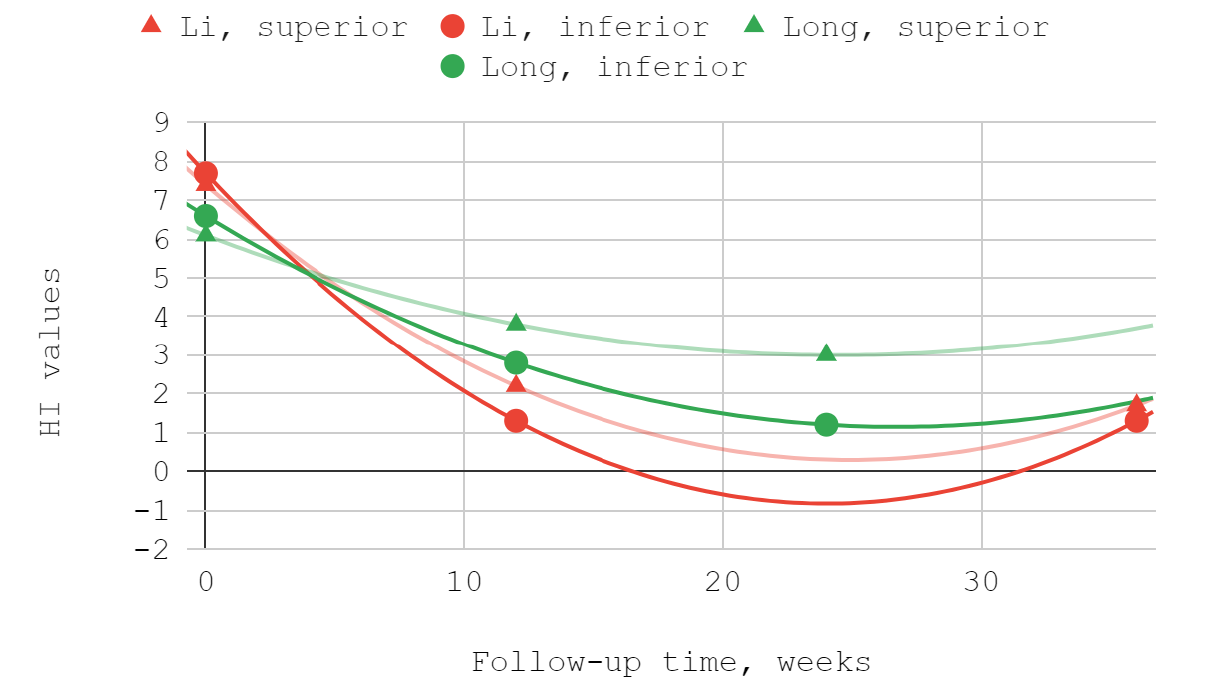
Figure 4. Helkimo index (HI) over time.